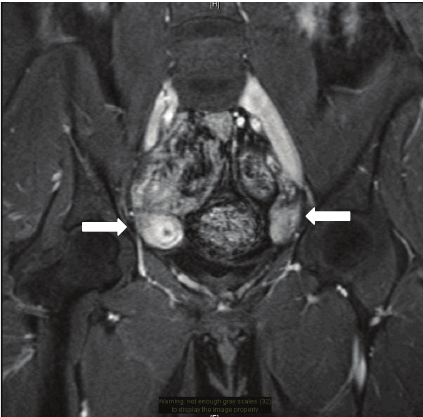
Figure1:Coronalmagneticresonanceimaging(MRI)scanshowing twomassesseenatbilateralpelvicsidewallsdemonstratingenhance- ment patterns suggestive of possible uterine tissue (arrows). The right and left masses measured 3.2 × 1.9 cm and 2.9 × 1.6 cm in the maximum dimensions, respectively.